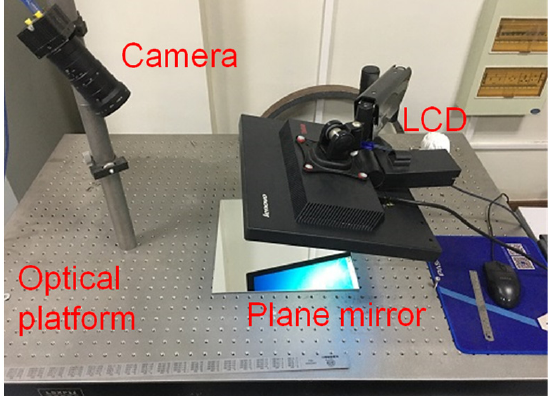
Figure 5. Experiment setup. The whole measurement system consists of an optical platform, standard plane mirror, LCD monitor, and large FOV camera.